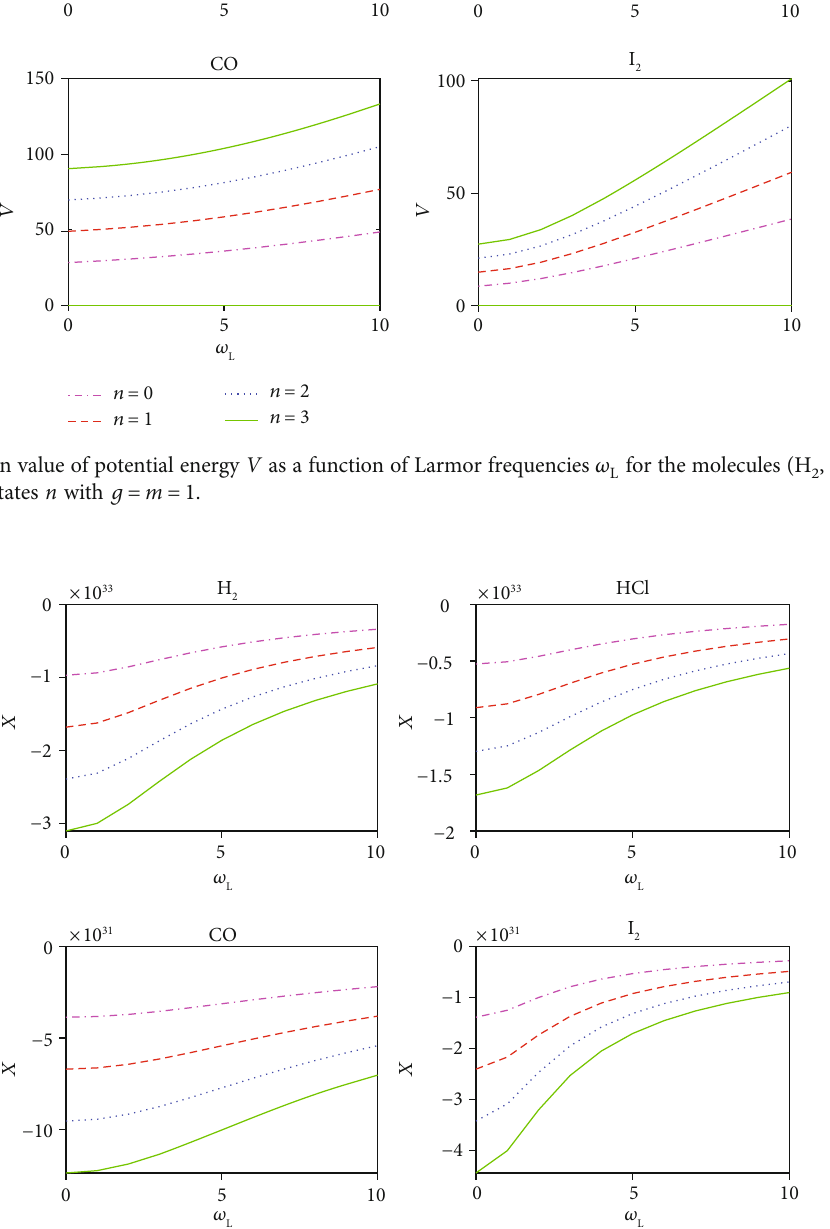
for the molecules (H , HCl, CO, and I ) and various L 2 2